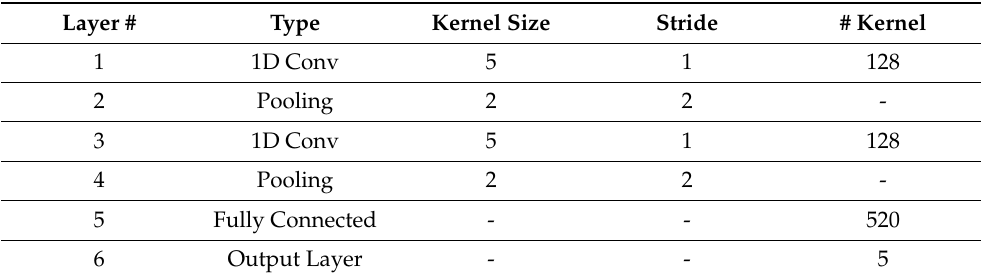
Figure 3. Proposed 1D CNN Model Architecture. Table 1. The architecture of the proposed 1D CNN